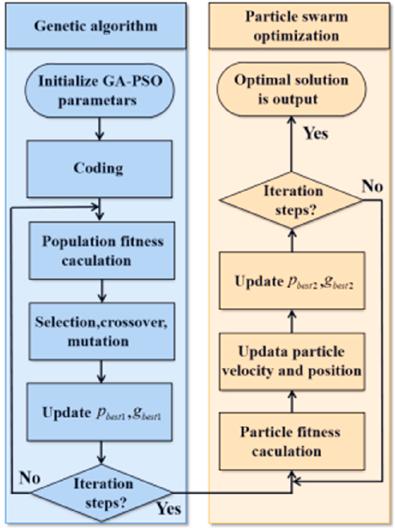
Figure 9. GA-PSO flow chart.